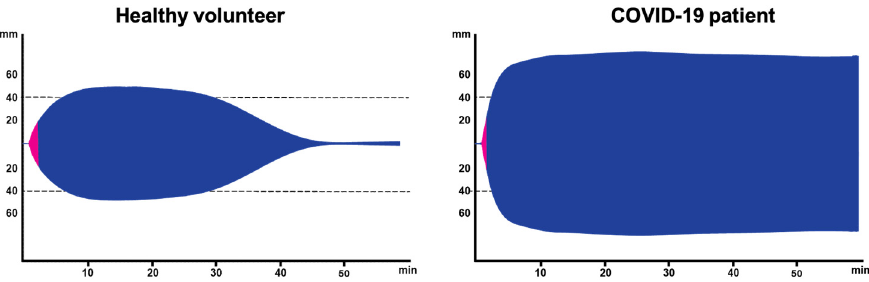
Figure 3. Representative example of a ROTEM outcome in a healthy volunteer and in a COVID-19 patient. 19